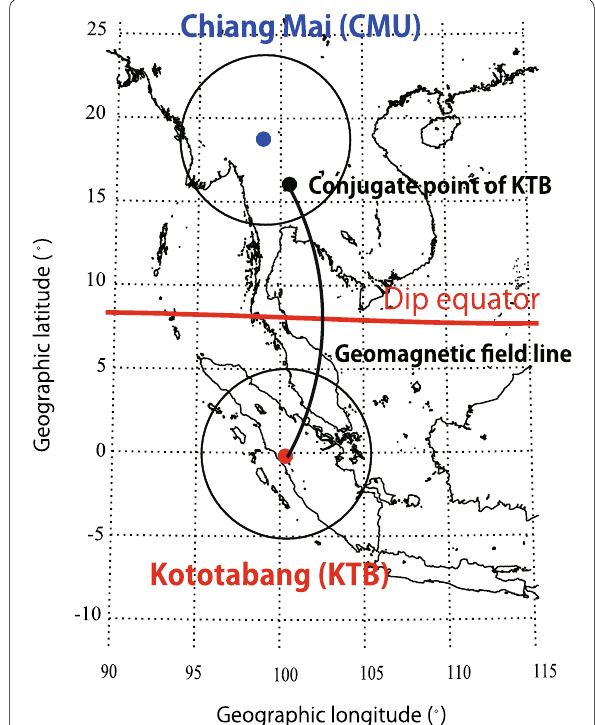
Fig. 1 Location of Kototabang (KTB) and Chiang Mai (CMU). The geomagnetically conjugate point of Kototabang is shown by the black dot . The circles show the field of view of the all-sky imagers at KTB and